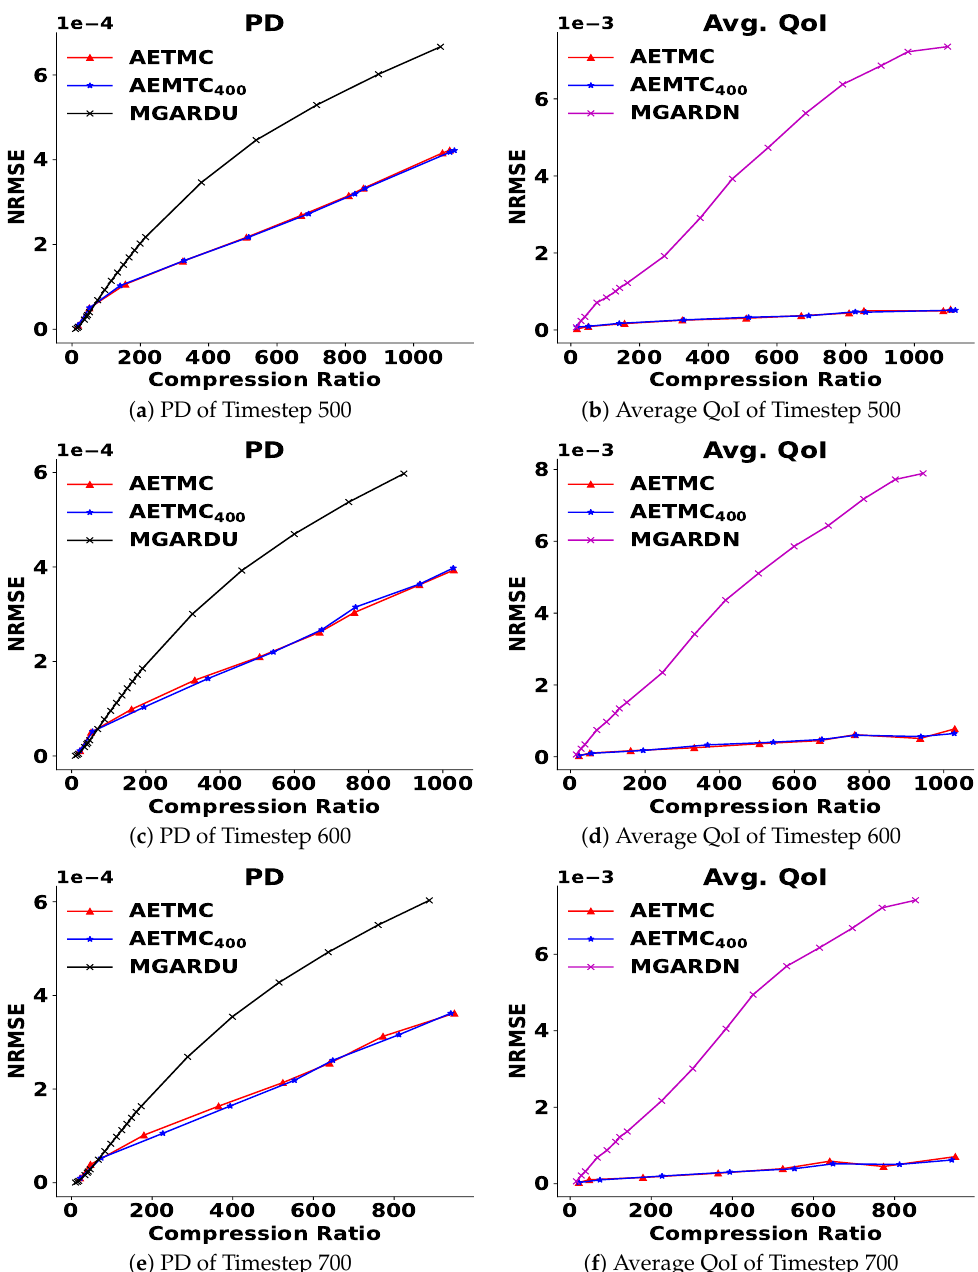
Figure 7. Running the AETMC framework with test data: The AE ( AETMC 400 ) is trained at timestep 400 and tested at timesteps 500, 600, and 700 with comparisons against separately trained AETMC